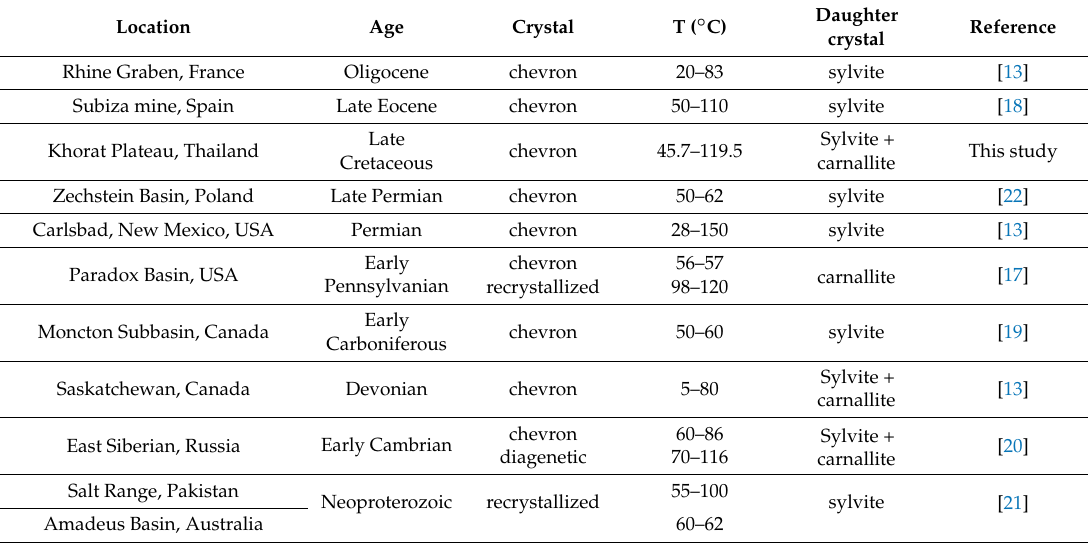
Table 1. Range of dissolution temperatures of sylvite and carnallite daughter crystals in fluid inclusions in halite, Neoproterozoic to Eocene in